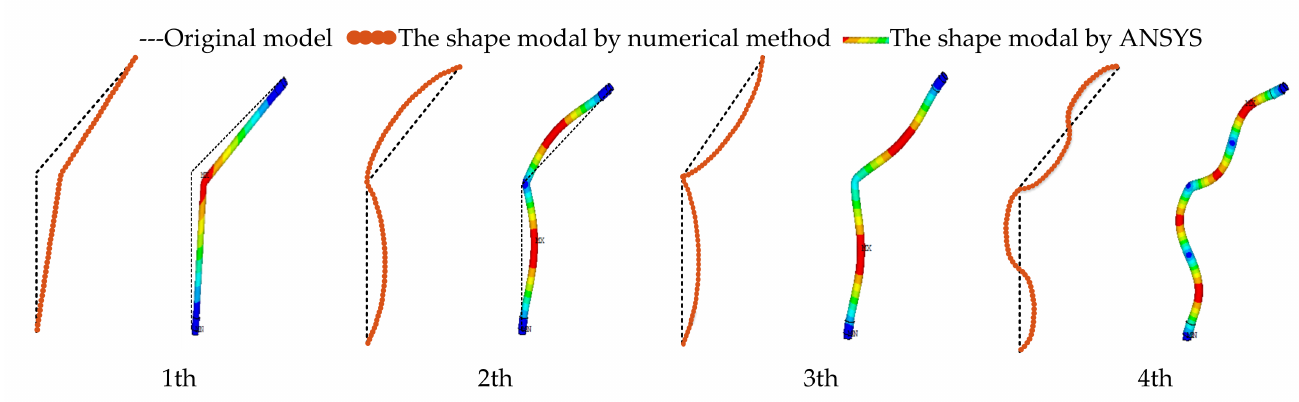
Figure 4. The comparison of the first four shapes in different ways.